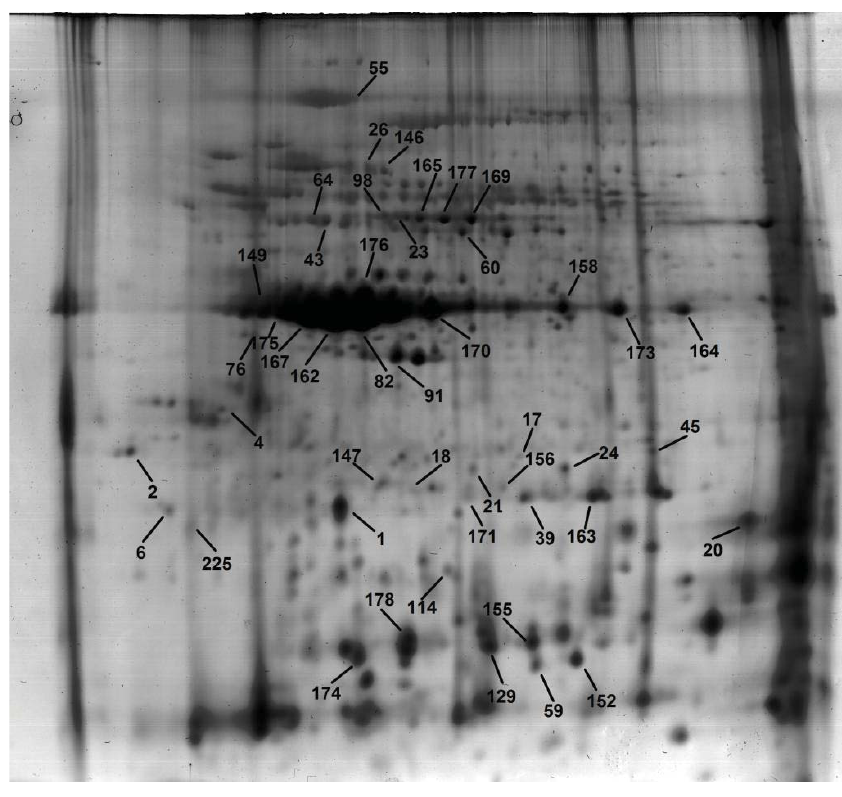
Figure 5. 2D reference gel image of potato tuber proteome used for inference of protein function by gel matching to published potato tuber proteome